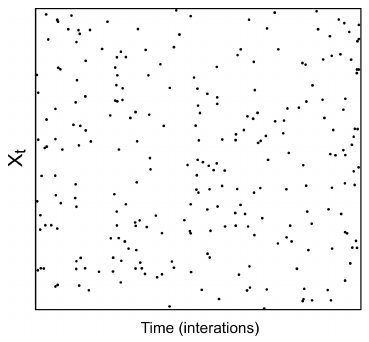
Figure 7. The iterated functions system (IFS) test applied to the time series of the number of hurricanes that occurred in the Gulf of Mexico and the Caribbean Sea between the years 1749 and 2012.